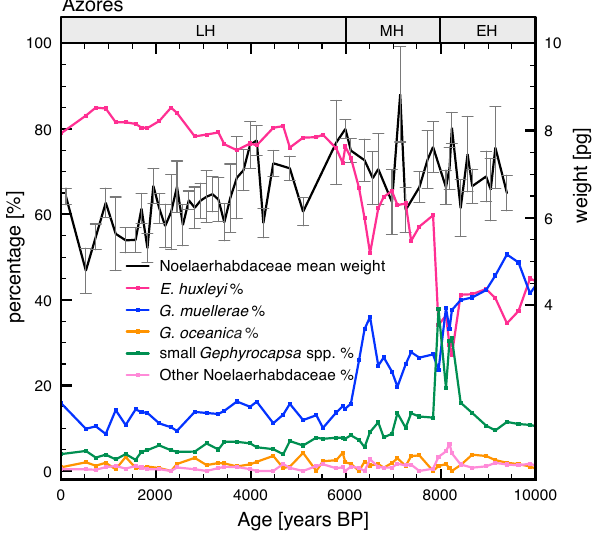
Fig. 5. Relative abundance of Noelaerhabdaceae species at the Azores from sediment core Geofar KF 16 over the Holocene (Schwab et al., 2012): E. huxleyi (red line), G. muellerae (blue line), G. oceanica (orange line), small Gephyrocapsa (green line) and other Noelaerhabdaceae (light-red line) in comparison to the Noelaerhabdaceae mean coccolith weight (black line).